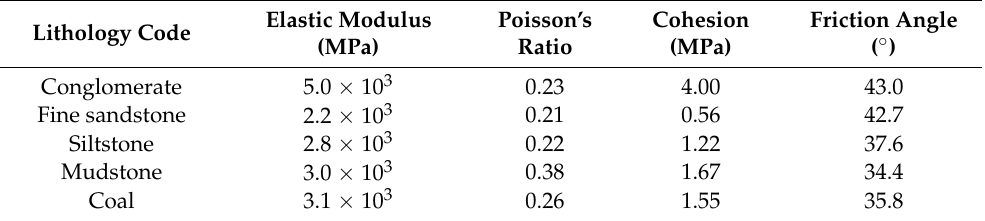
Table 3. Mechanical parameters of coal and rock strata in the numerical